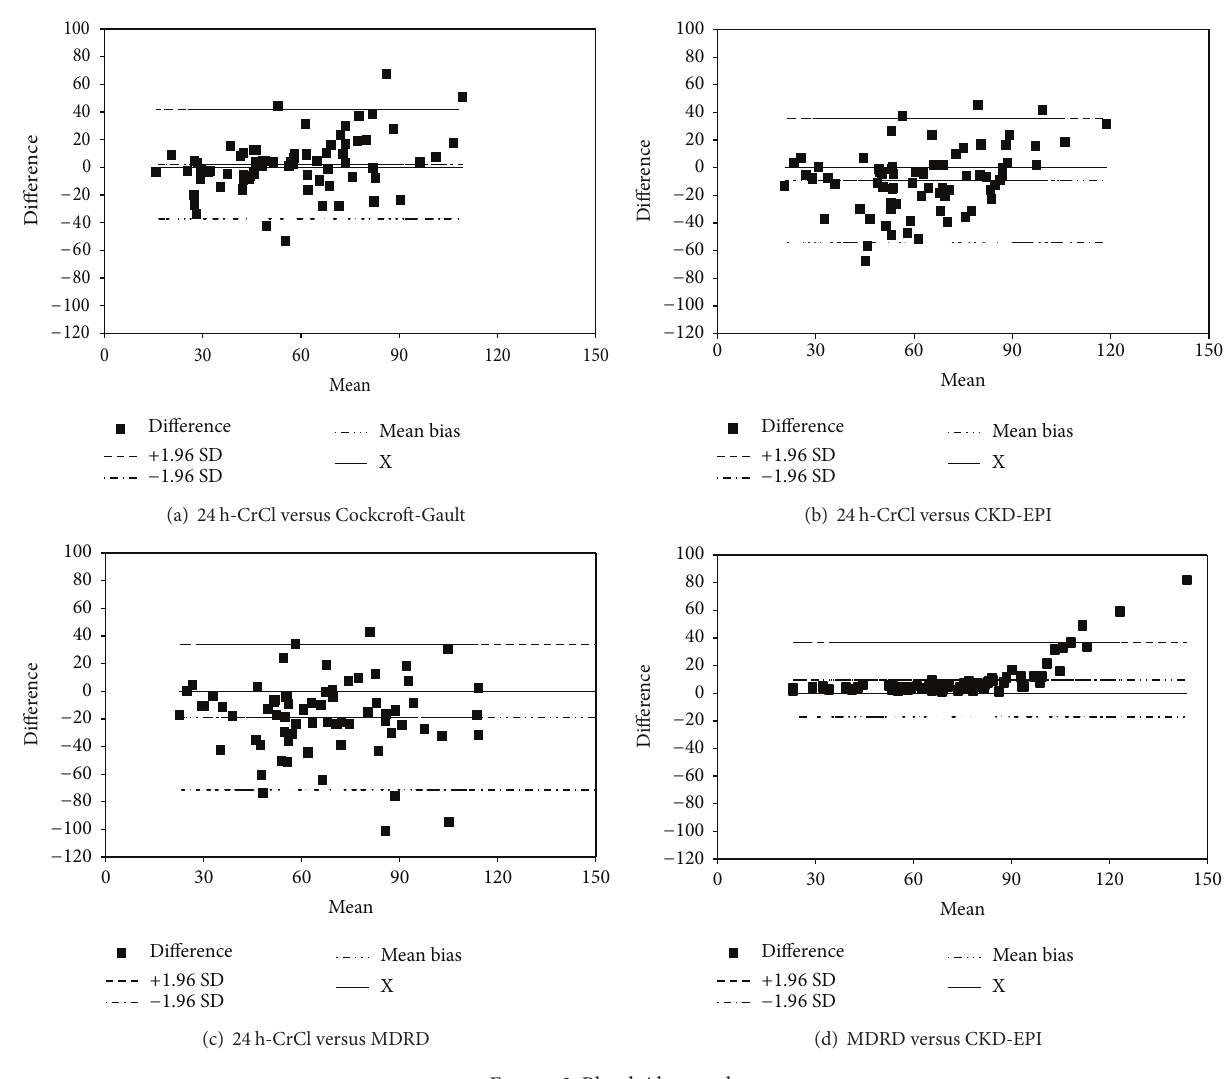
Figure 2: Bland-Altman plot. Table 2: Overall performance of difference and accuracy between 24 h-CrCl and estimated